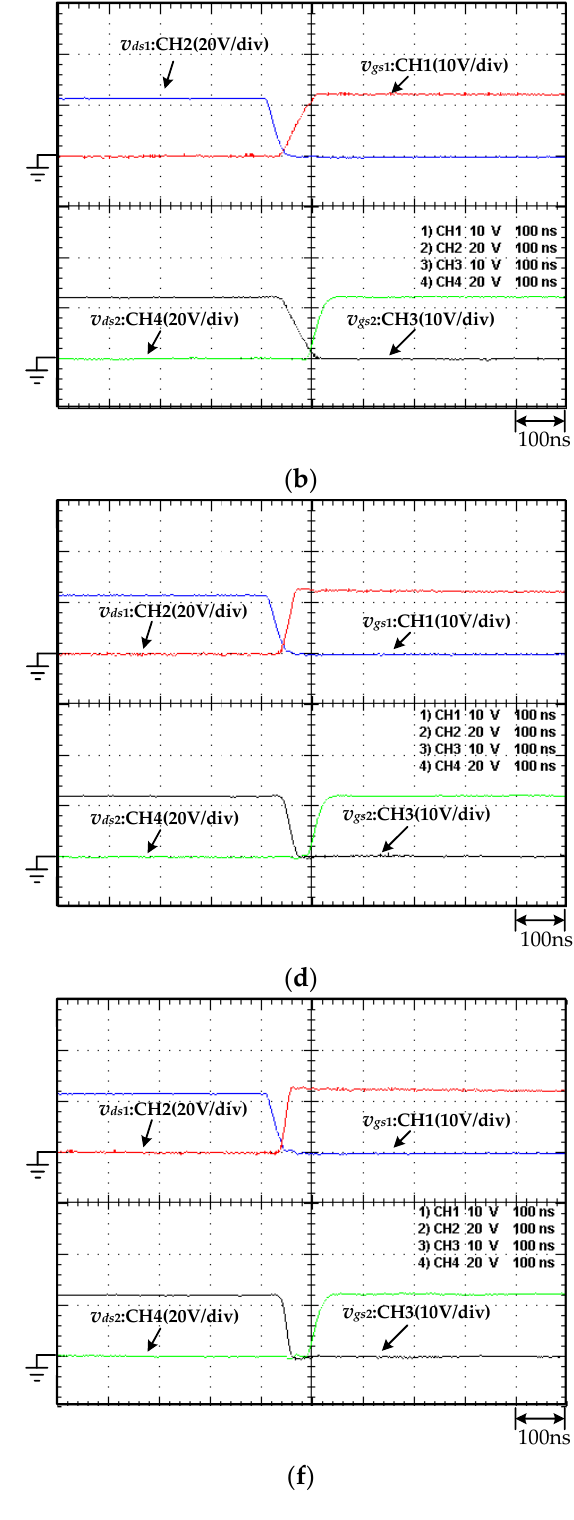
Figure 9. Measured waveforms of v gs 1 , v ds 1 , v gs 2 , and v ds 2 at input 24 V under ( a ) Q 1 turned-on at 10% load; ( b ) Q 1 turned-off at 10% load; ( c ) Q 1 turned-on at half load; ( d ) Q 1 turned-off at half load; ( e ) Q 1 turned-on at full load; and ( f ) Q 1 turned-off at full load.